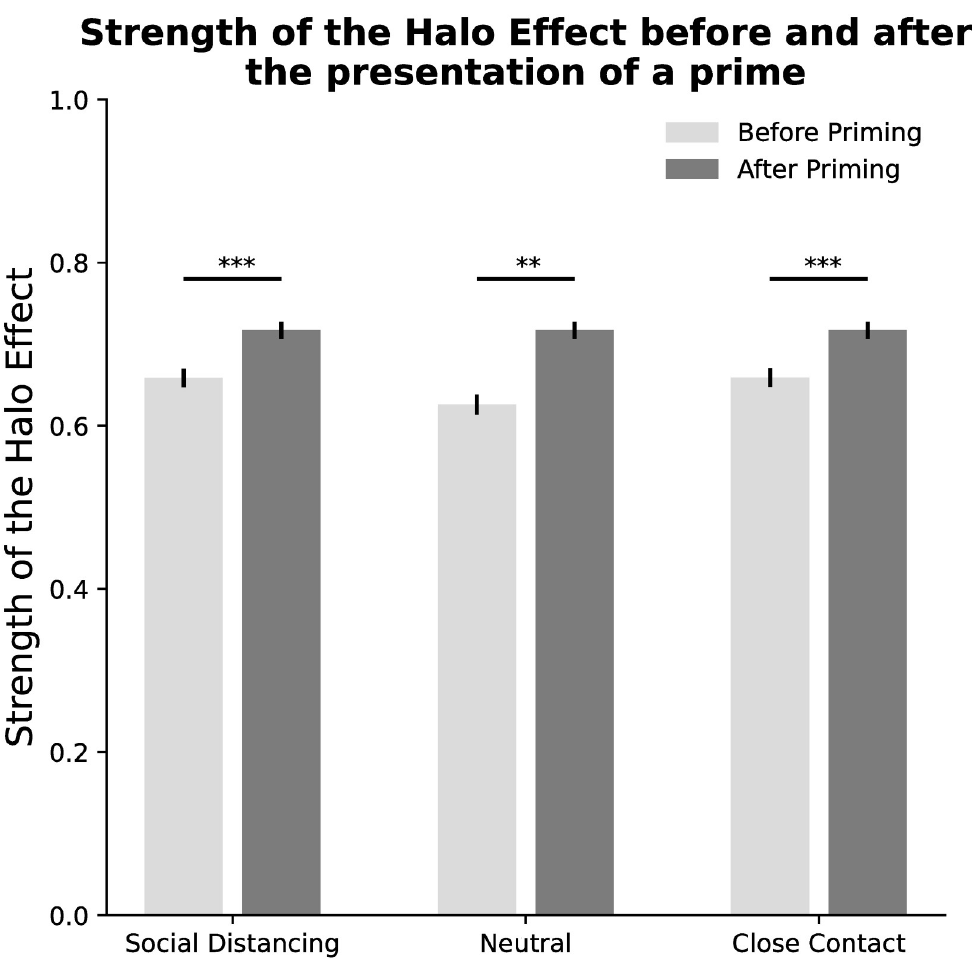
Fig 2. Strength of the Halo Effect, measured as Pearson’s correlation (mean and standard error) between Aesthetics and Trustworthiness ratings, by condition. �� p < 0.01, ��� p < 0.001.